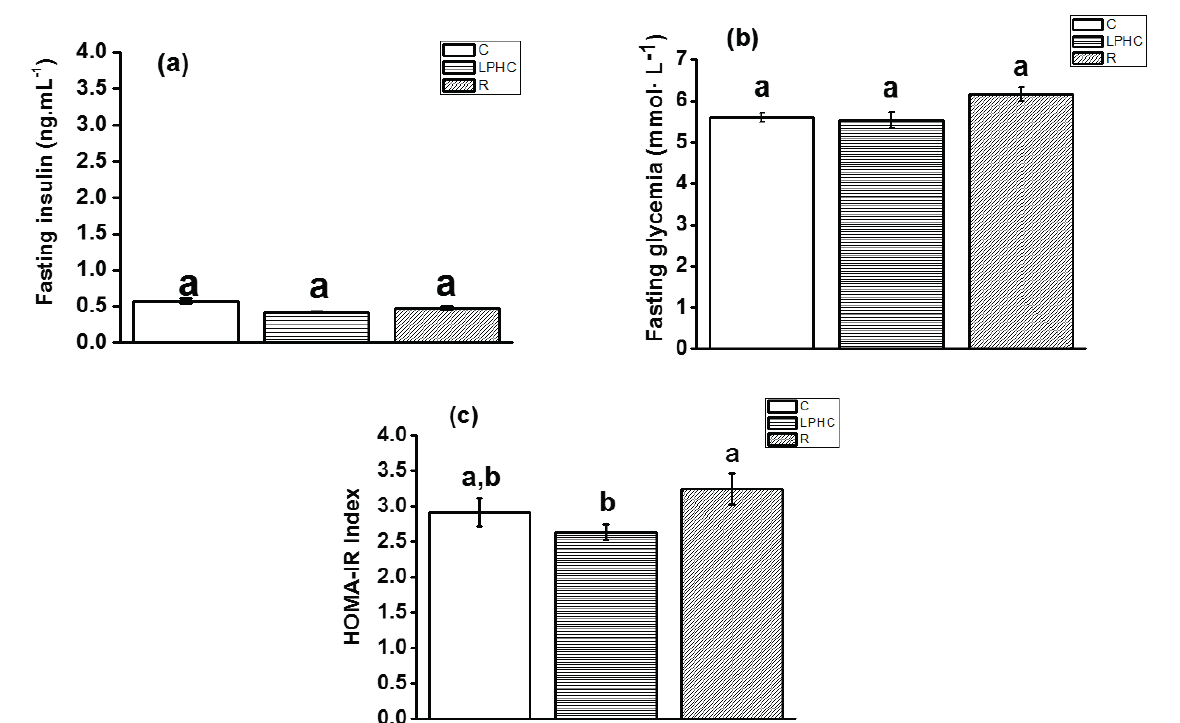
Figure 2 - Serum fasted insulin ( a ), glycemia ( b ) and HOMA-IR index ( c ) of rats fed a control diet or a low-protein, high- carbohydrate (LPHC) diet for 45 days (C and LPHC , respectively) and rats fed an LPHC diet for 15 days followed by the control 45 45 diet for 30 days (R). Results are expressed as means ± standard errors of the means across eight animals per group. letters indicate a significant difference among groups. One-way ANOVA, F = 2.19 for insulin; F = 1.04 for glycemia; F = 4.40 for HOMA-IR Index (p <